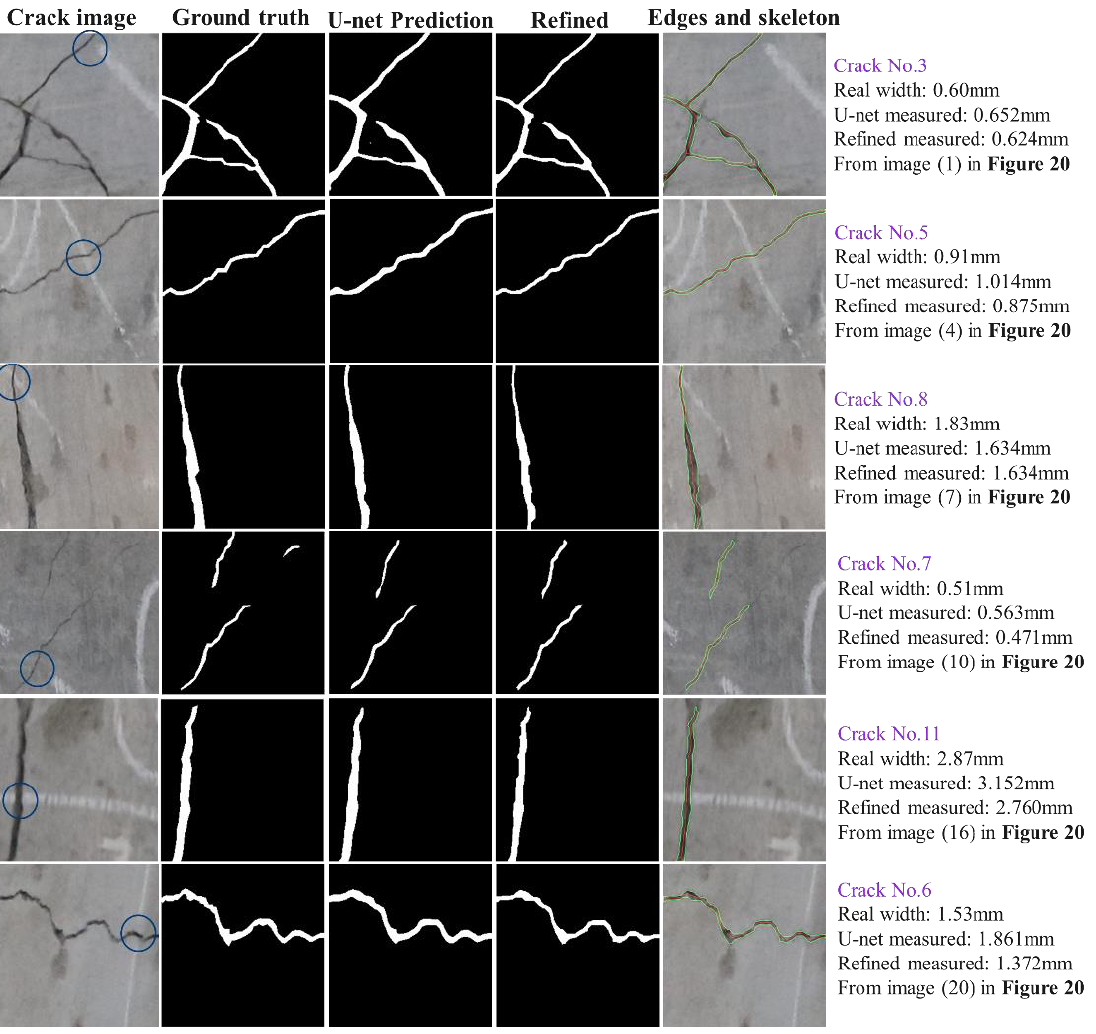
Figure 21. Examples of crack segmentation on concrete wall; the blue circle is the location of crack width measurement.